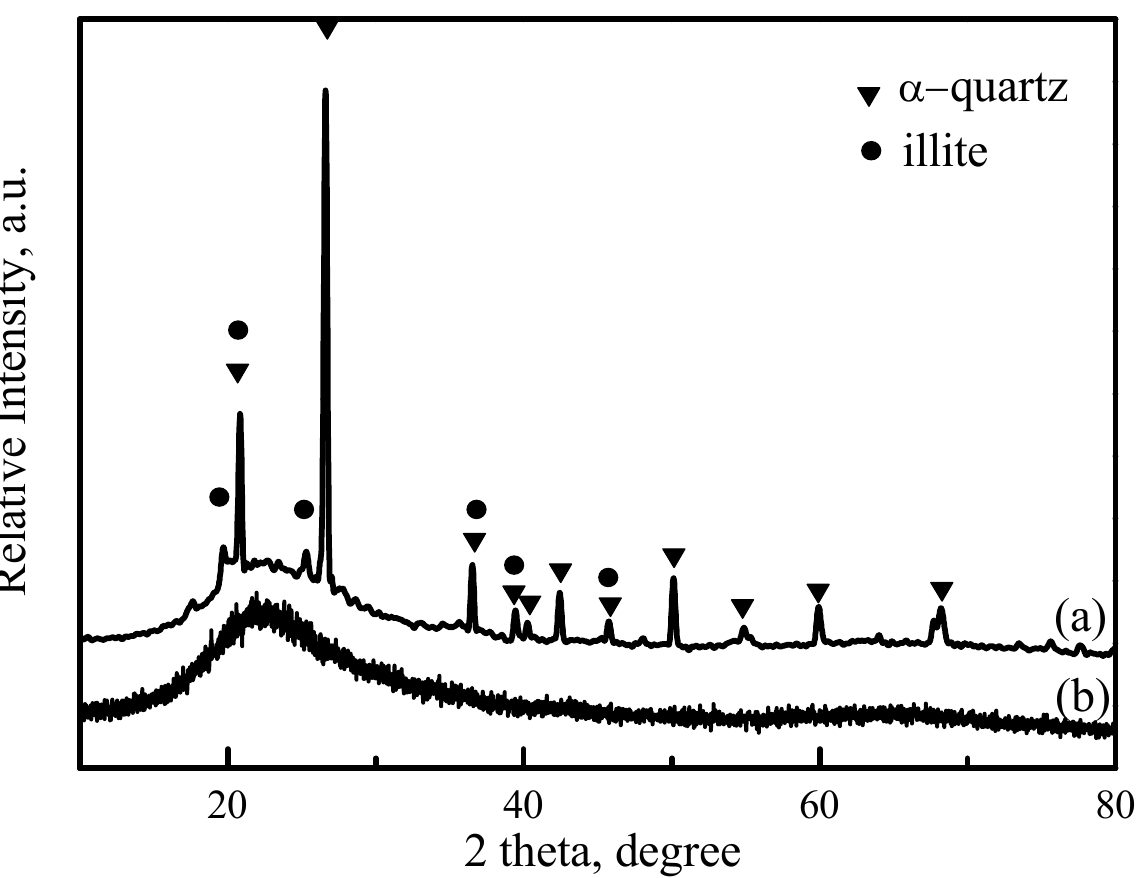
Figure 3. XRD patterns of (a) natural metakaolin (N-MK) and (b) synthetic metakaolin (S-MK). Figure 4a,b demonstrates the microstructure of the N-MK and S-MK samples; the N-MK powder showed laminar and needle-like microstructure and an average size about 10.0 µ m, and the S-MK presented a smaller particle size (about 3.0 µ m) and a more homoge- neous particle size distribution. Particle aggregation was also displayed both in the N-MK and S-MK samples. To further compare the particle size and particle size distribution, the particle size distribution was also investigated and are shown in Figure 4c,d, where a rather large size distribution is displayed. The D 50 (average particle size) of N-MK and S-MK were 14.2 µ m and 3.1 µ m; the average particle size data of S-MK was in keeping with